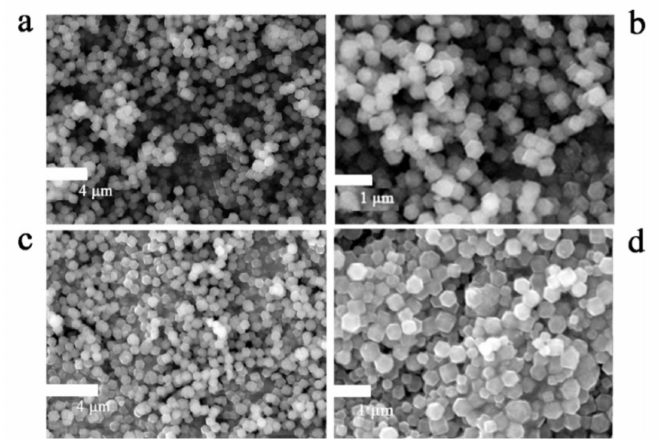
Figure 4. SEM ( a – d ) images of ZIF-8, HPNCs-800, ZIF-8/GO, and HPNCs/rGO-800. Reprinted with permission from Xin, Lijun, et al. Hierarchical metal-organic framework derived nitrogen-doped porous carbon/graphene composite for high performance supercapacitors. Electrochim. Acta 2017, 248, 215–224. [19] Copyrights © 2017 Elsevier Ltd.